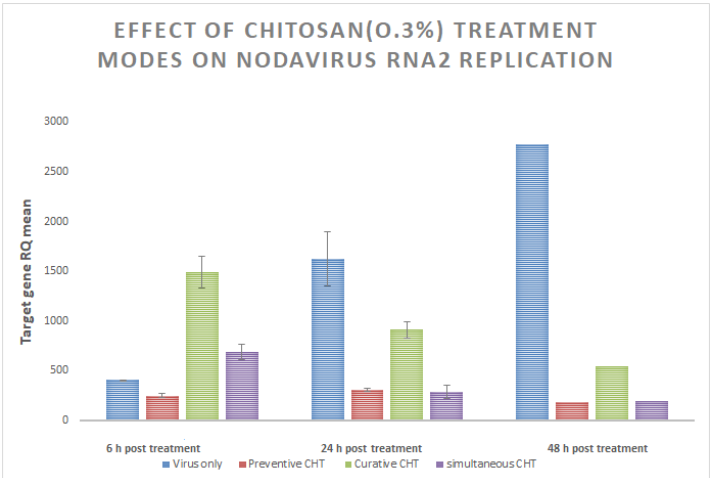
Figure 3. Expression of nodavirus capsid protein (CP) gene in E-11 at different times points (6, 24 and 48 hours post treatment) following treatment of Chitosan (CHT) at 0.3%. Three different modes were tested: preventive mode (mode 1: red bars), curative mode (mode 2: green bars) and simultaneous mode (mode 3: purple bars) for the evaluation of the chitosan effect on nodavirus RNA replication. Nodavirus only inoculated cells are shown in blue bars. Fold expression was calculated as 2 − ∆∆ Ct . Control group (no CHT treatment) was used as the calibrator.